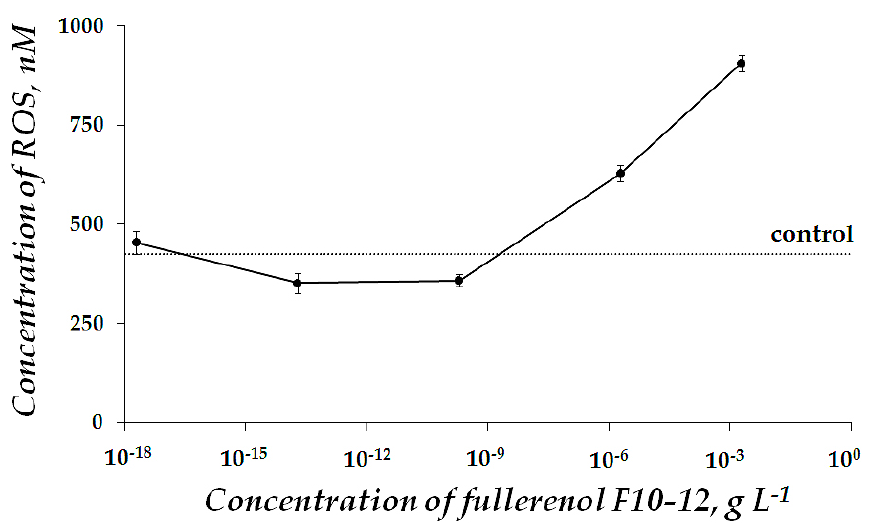
Figure 6. ROS content in the enzyme system in the presence of 1,4-benzoquinone (10 − 5 M) vs. concentration of F10-12. Incubation time was 15 min, pH 6,8. ROS content in the control sample was 427 nM.